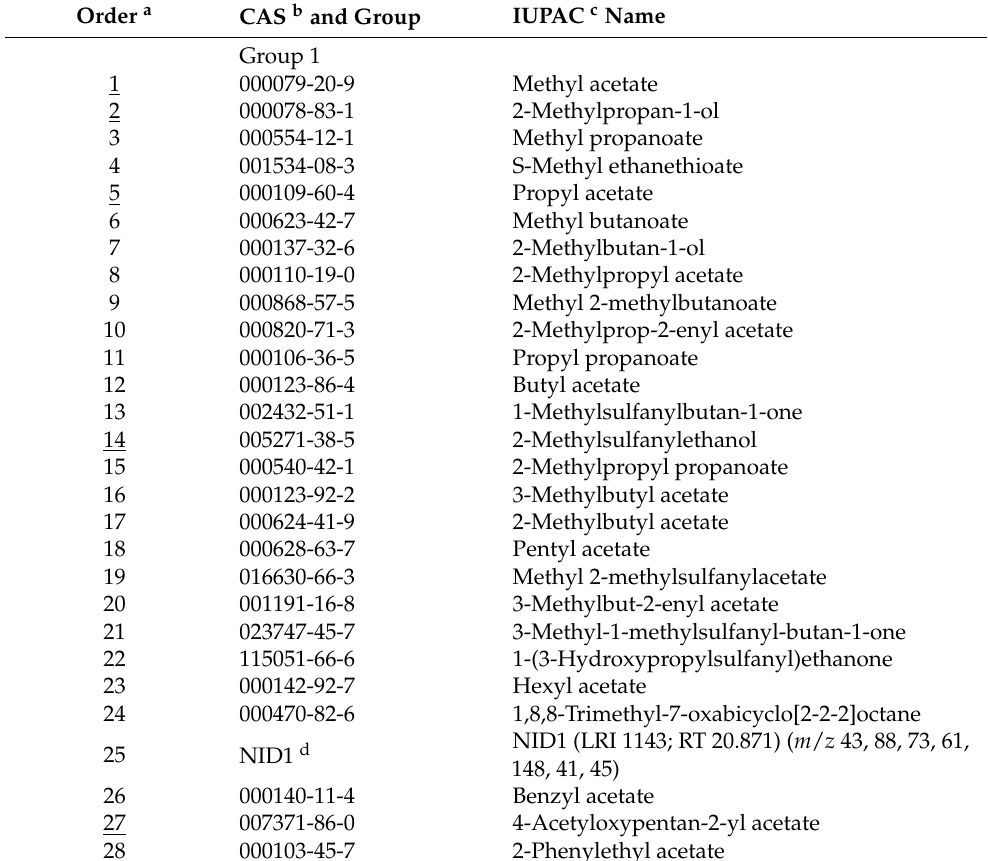
Table 5. Groups with at least two compounds and correlations above 0.7 in absolute value were obtained by correlation network analysis (CNA) applied to melon aroma volatile compounds. The chemical and sensory attributes of the compounds are in Table S6. Order